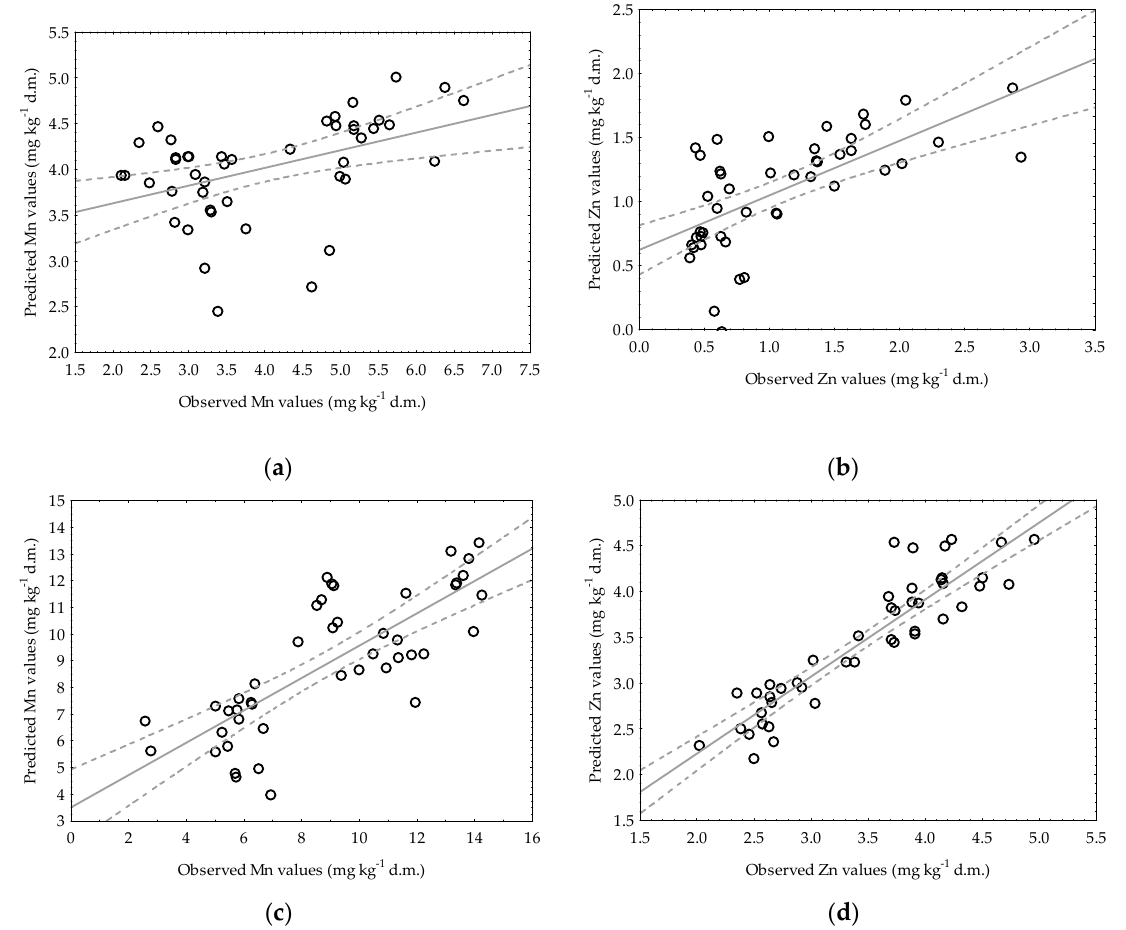
Figure 7. Observed Mn and Zn contents in very light ( a , b ) and heavy soils ( c , d ) versus predicted data generated by the developed simplified regression models.